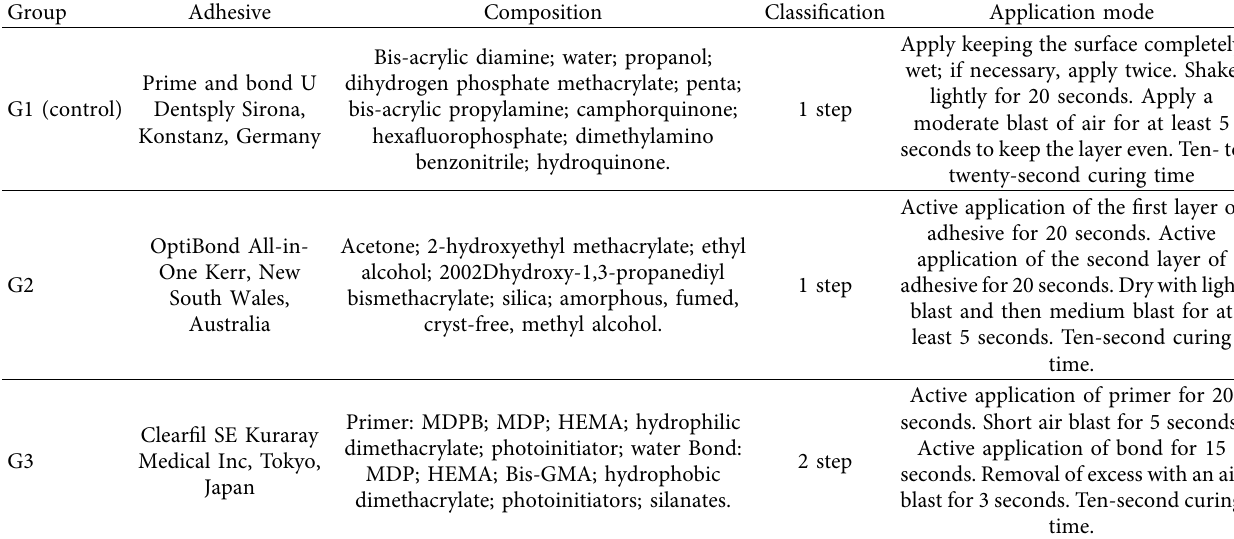
Table 1: Experimental groups ( n � 16 per group).